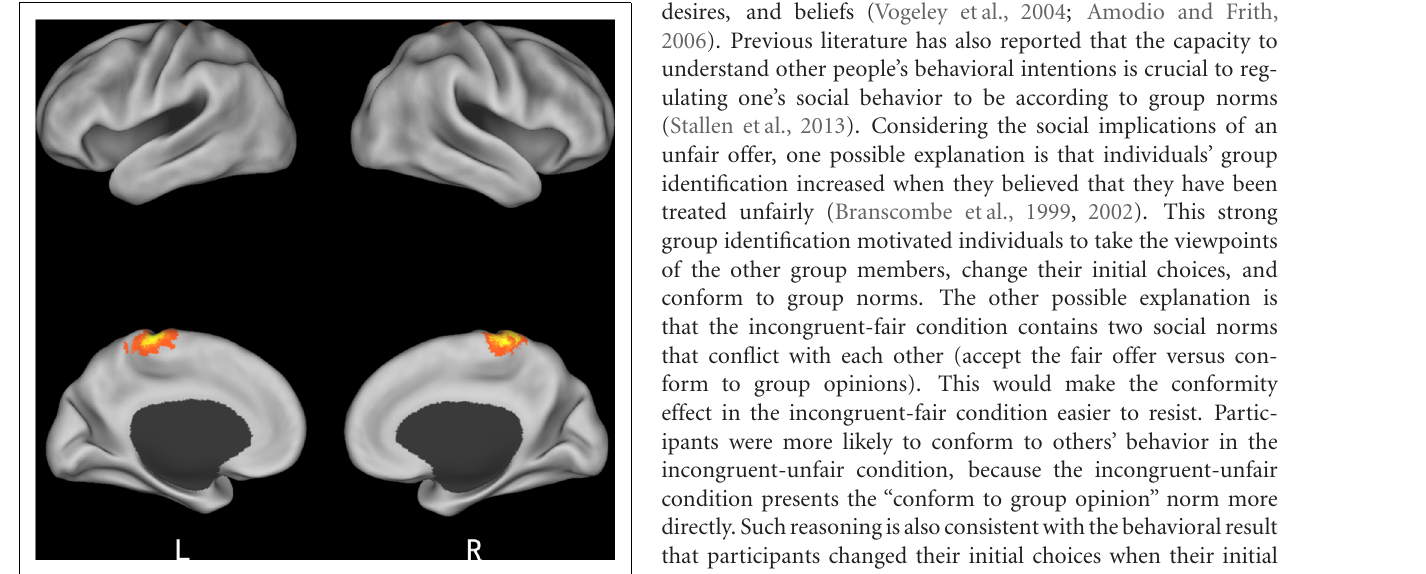
FIGURE 5 | Brain regions involved in the interaction of offer type and social influence when subjects viewing others’ choices after they rejected the offer in the first decision